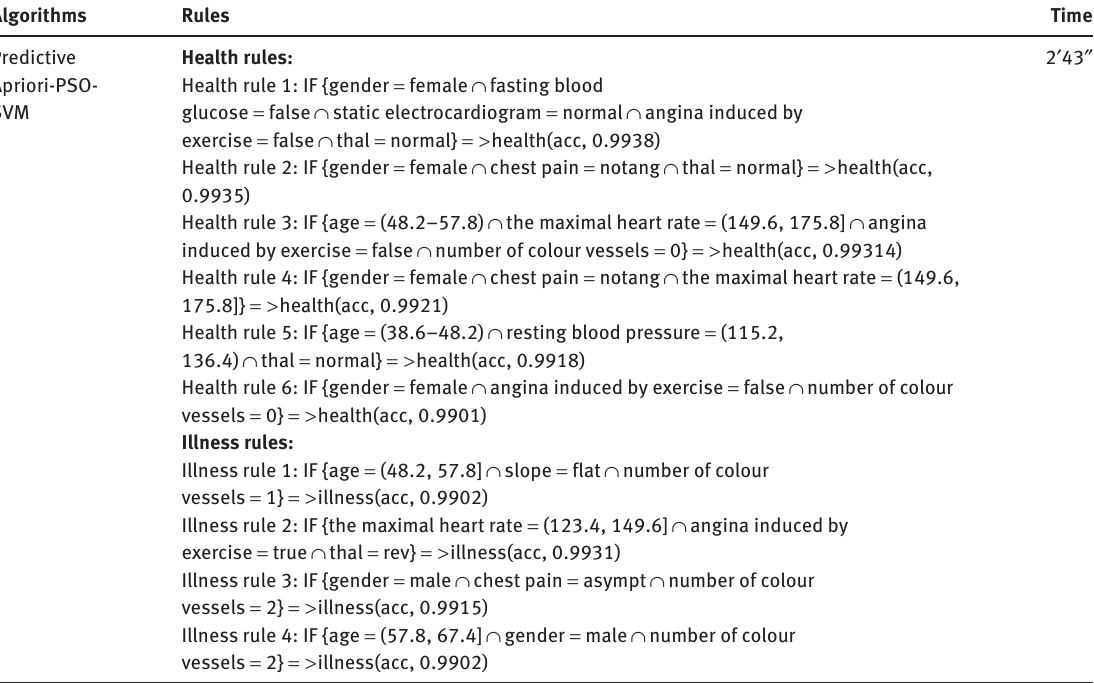
Table 2: Health and Illness Rules Extracted Using the Predictive Apriori Algorithm. Algorithms